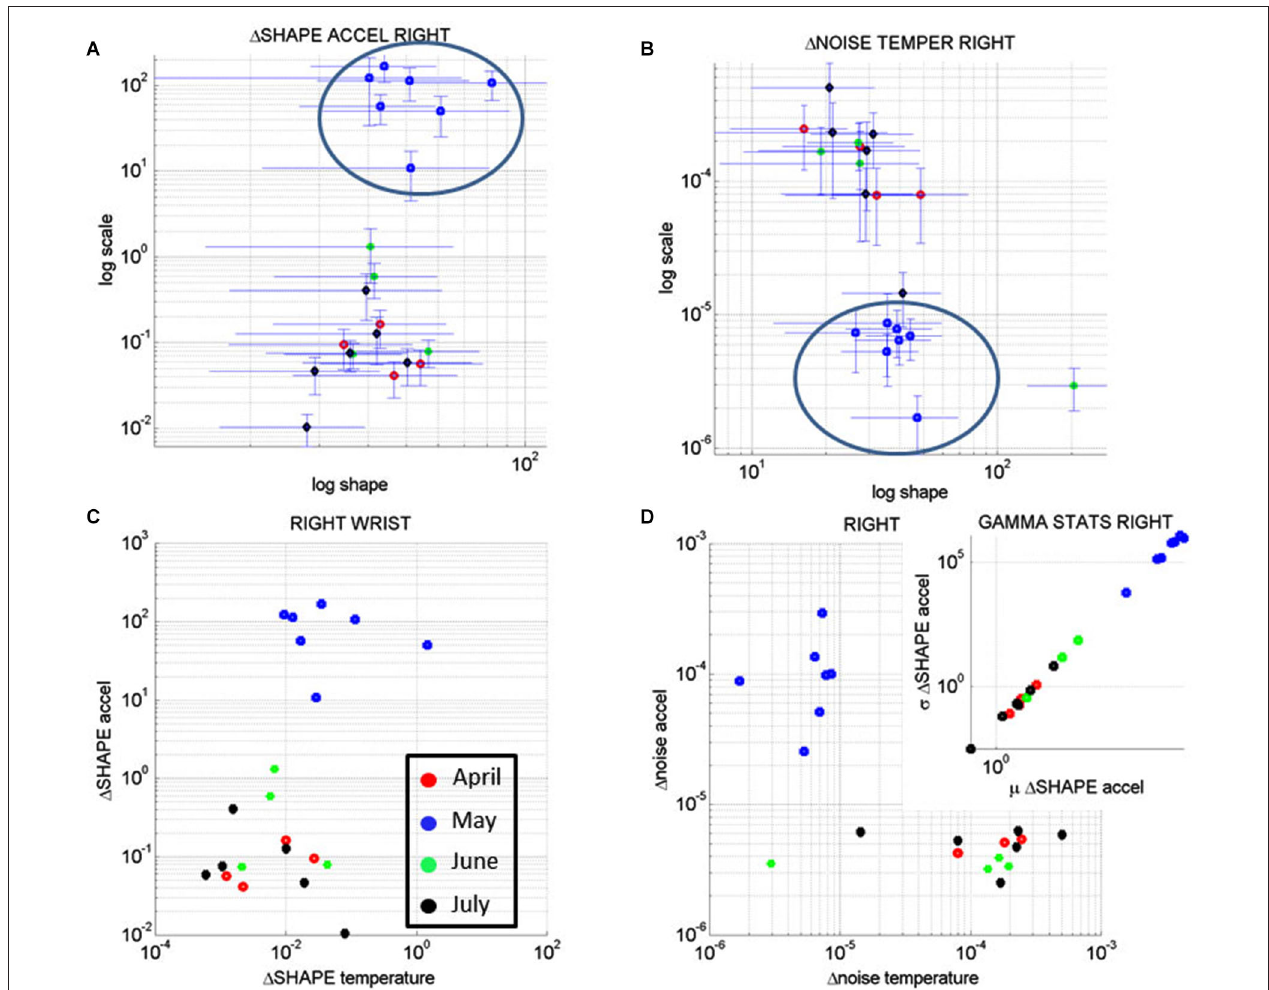
compared to the other months. (C) The rates of change in the shape of the distributions characterizing the noise-to-signal levels of the acceleration as a function of the temperature were systematic during the month of May and clustered apart from the readings of the other months. (D) The stochastic signatures of the rates of change in the noise-to-signal levels of the acceleration expressed as a function of those of the temperature also clustered apart in May from the rest of the recordings in other months. Inset shows the estimated Gamma statistics for the rate of change in the shape of the Gamma distribution corresponding to the acceleration parameters with systematic increases in the variability of the maximal deviation from the average acceleration with increases in the mean value of this